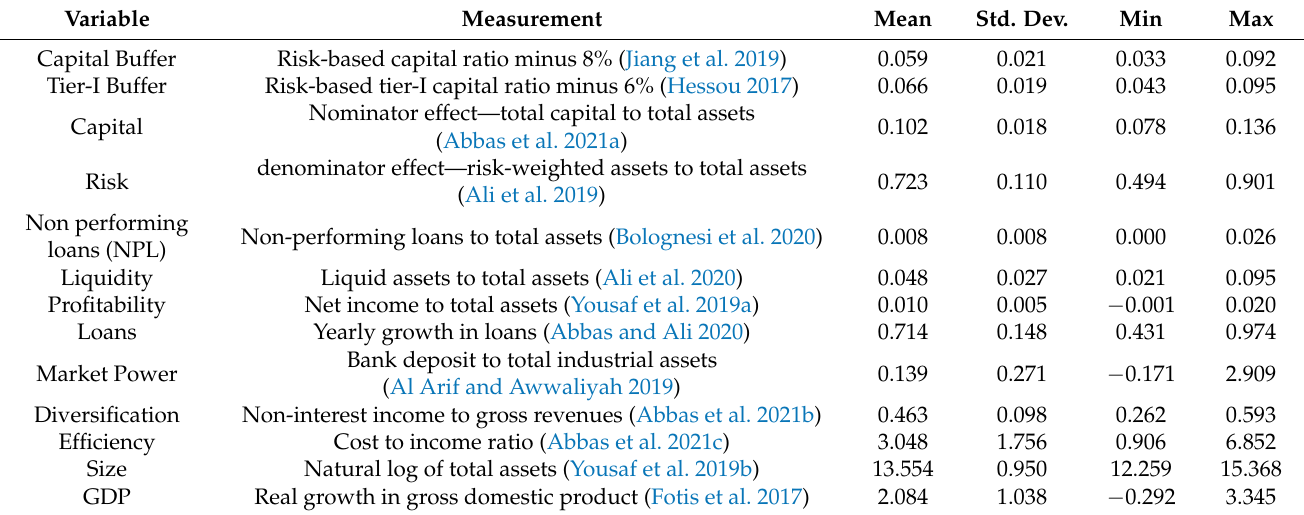
Table 1. Variables measurement and descriptive